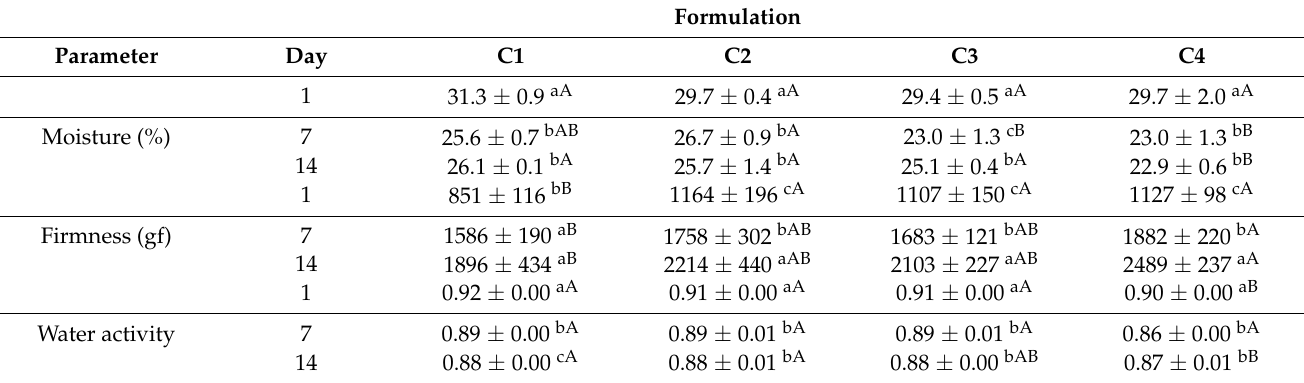
Table 4. Moisture, firmness, and aw parameters of cakes made with different fats during 14 days of